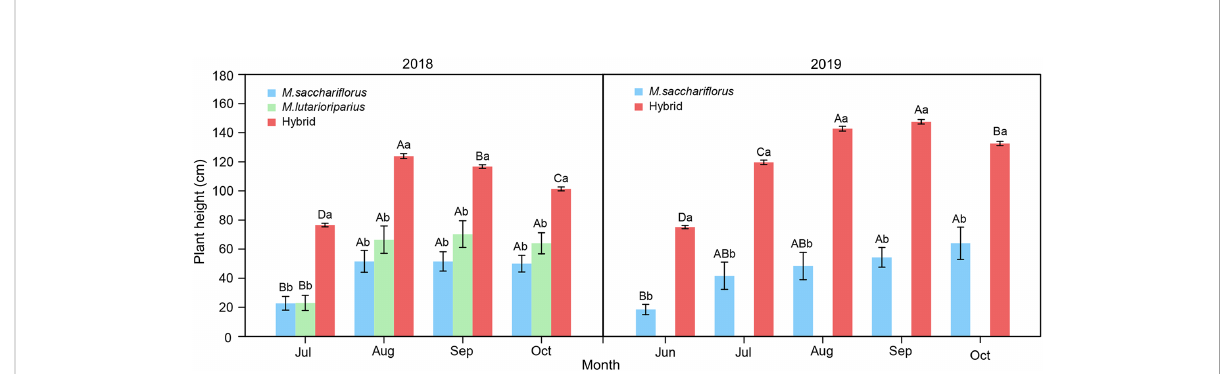
FIGURE 2 Differences of average plant height between measuring hybrid and female parent individuals throughout growth months in two growing seasons, and male parent individuals throughout growth months in the 2018 growing season. Different capital letters A, B, and C represent a signi fi cant difference of plant height between growth months at P <0.05 level, respectively. Different lowercases a and b represent a signi fi cant difference of M. sacchari fl orus , M. lutarioriparius and their hybrids at P <0.05 level, respectively. Error bars indicate standard error of 333 surviving hybrid individuals, 5 and 3 surviving female parent individuals in both 2018 and 2019, and 10 surviving male parent individuals in 2018,